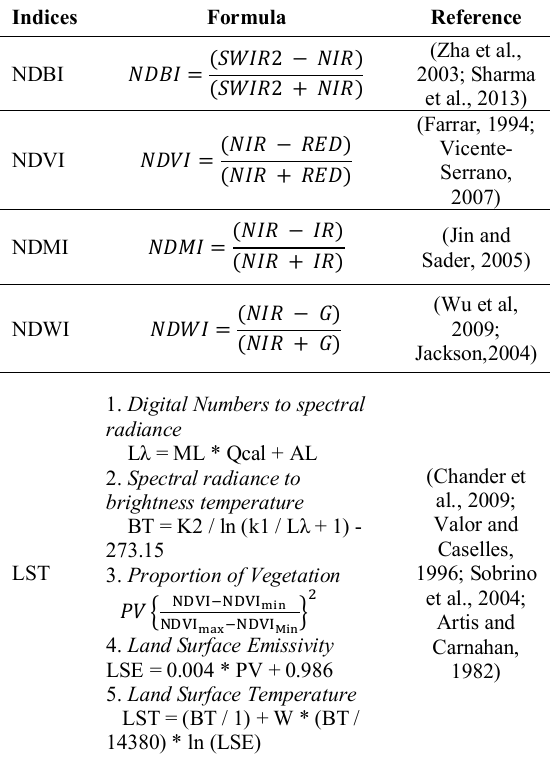
Table 1: Formula for calculating Remote Sensing Indices.